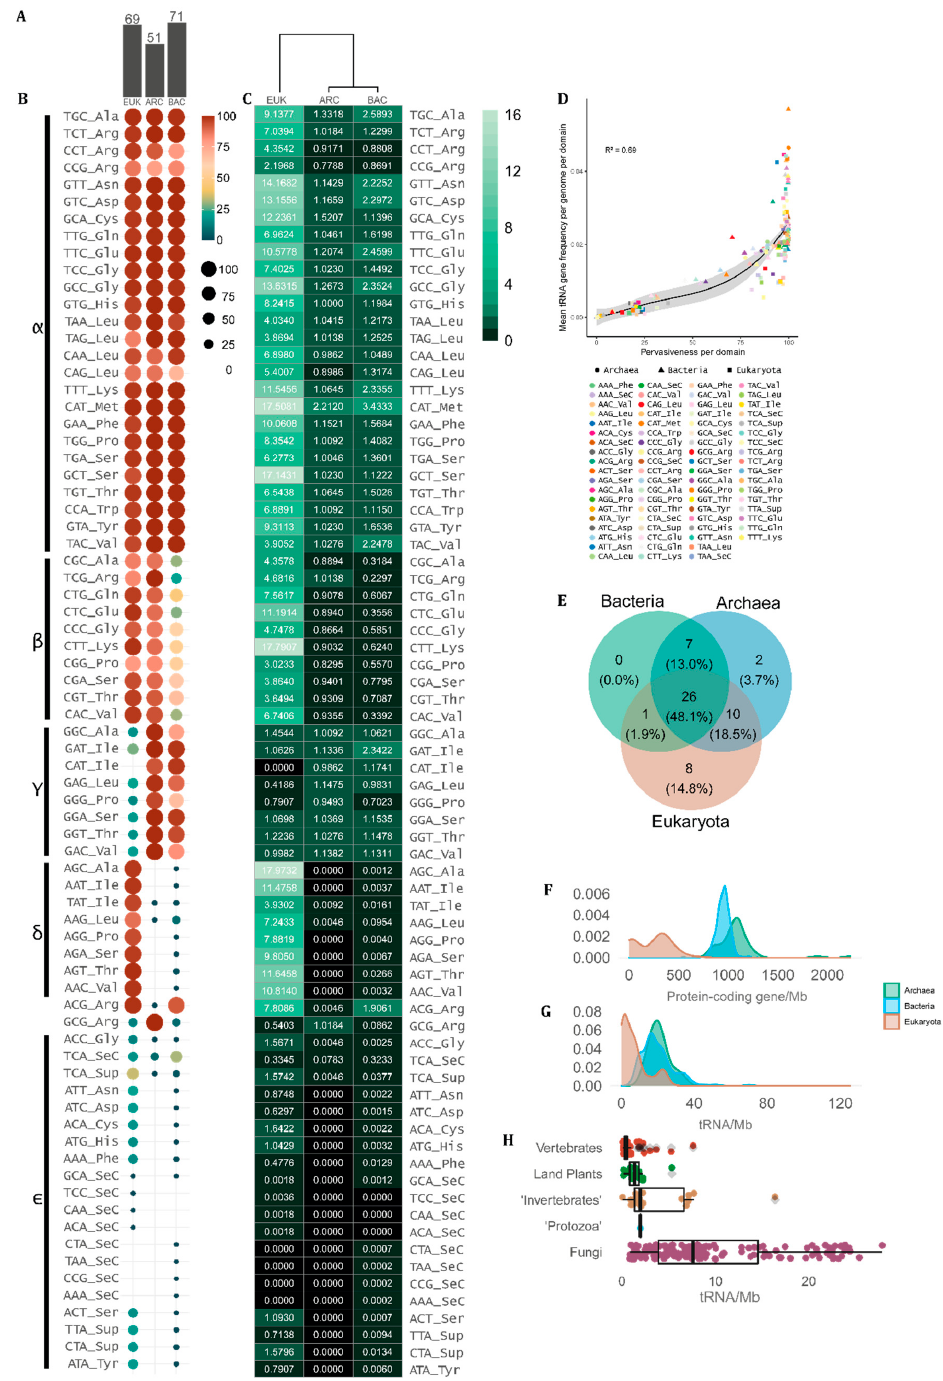
Figure 2. Occurrence and frequency tRNA amino acid/anticodon combinations in the genome of cellular organisms. ( A ) Number of tRNA combinations observed between amino acids and anticodons per domain (EUK = eukarya, ARC = archaea, BAC = bacteria). ( B ) tRNA pervasiveness (% of genomes) and ( C ) mean tRNA count per domain. ( D ) Correlation between tRNA mean gene frequency per genome per domain and tRNA pervasiveness defined as the proportion of genomes containing each tRNA per domain. ( E ) Venn diagram showing the overlap between domains of the tRNA anticodons present in more than 70% of the genomes in each domain. ( F ) Distribution of the number of protein-coding and ( G ) tRNA genes per megabase (Mb) per genome per domain. ( H ) Boxplots showing the distribution of tRNA genomic density (tRNA genes/Mb) per genome in the main eukaryote